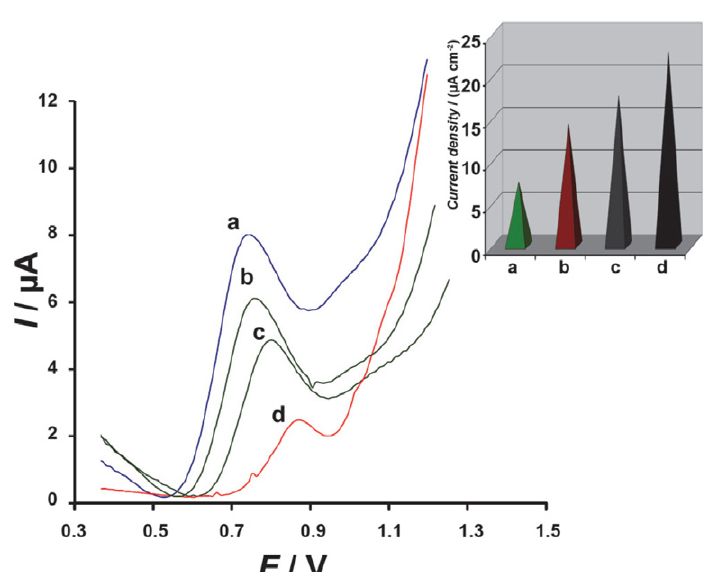
Figure 3. Linear sweep voltammograms of (a) CuO/1E3MIBF 4 /CPE, (b) 1E3MIBF 4 /CPE, (c) CuO/CPE, and (d) CPE in the presence of 100 µmol L −1 6-TG at pH 7.0. Inset: the current densities derived from voltammograms responses at same